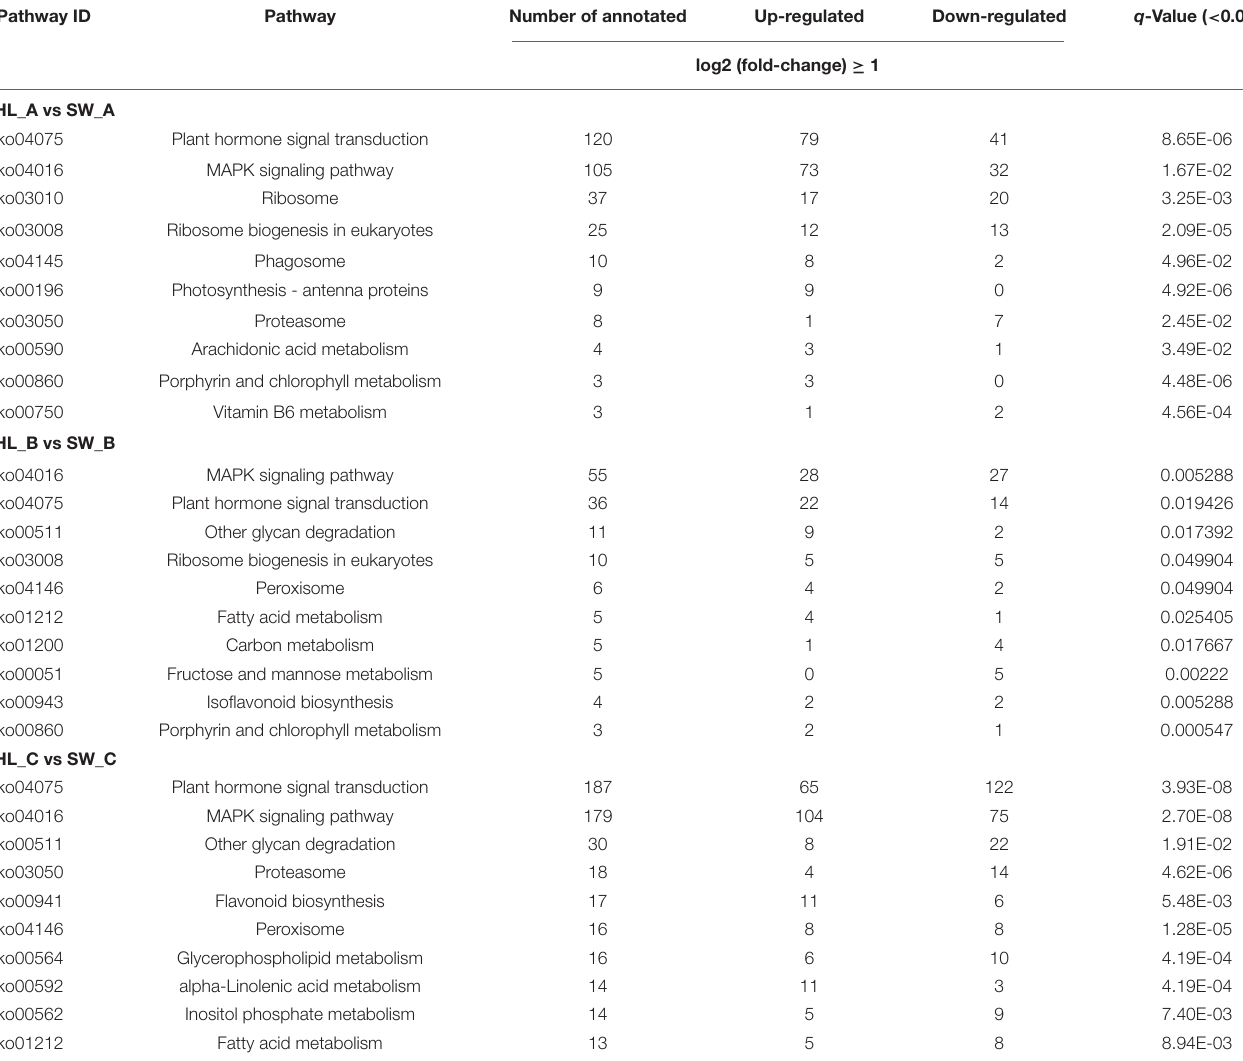
TABLE 2 | Significantly enriched pathways of differentially expressed genes (DEGs) among HL and SW samples through KEGG enrichment analyses at bud infestation stages A, B, and C. Pathway ID Pathway Number of annotated Up-regulated Down-regulated q -Value ( <